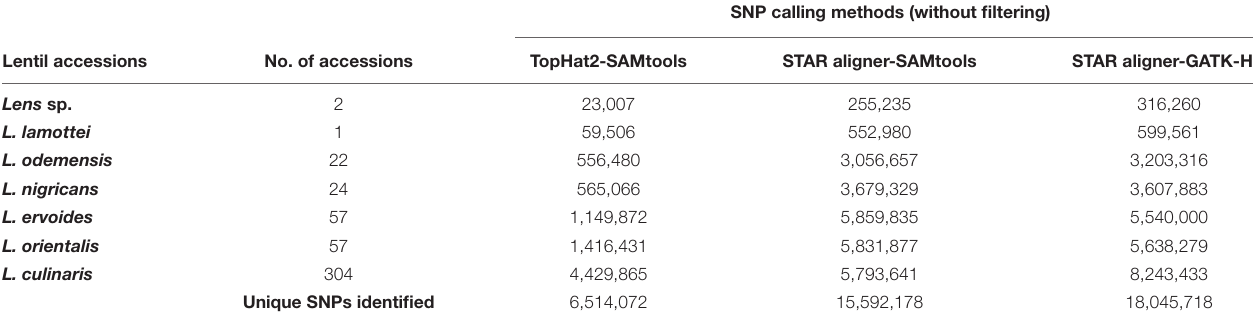
TABLE 2 | Number of SNPs identified through different data analysis